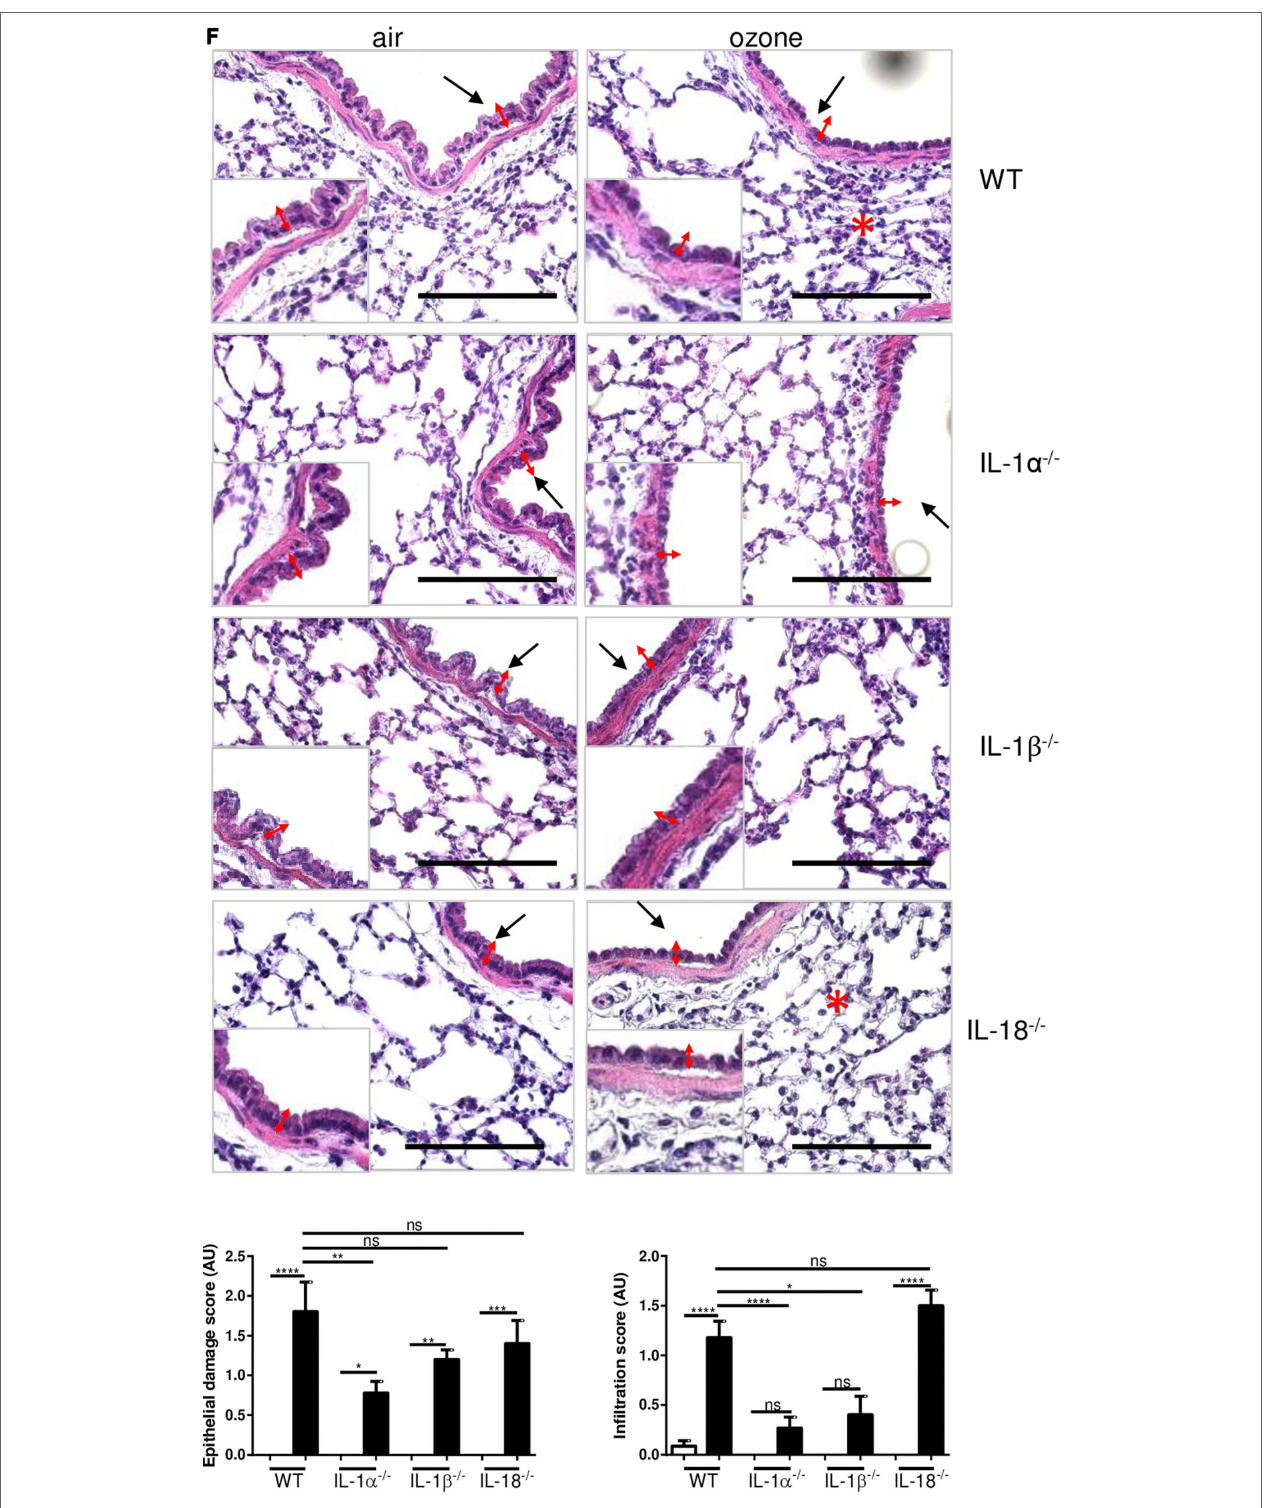
FigUre 2 | Inflammation in interleukin (IL-1) α − / − , IL-1 β − / − , and IL-18 − / − mice 24 h after ozone exposure. Total cells (a) , neutrophils and myeloperoxidase (B) , protein and lipocalin-2 (c) , tissue remodeling parameters, tissue inhibitor metalloproteinase 1, and matrix metalloproteinase 9 (D) , histology, scale bar = 100 µm (F) , in IL-1 α − / − , IL-1 β − / − , and IL-18 − / − mice and airway hyperreactivity in IL-1 α − / − mice (e) , and microscopic analysis of the lung (F) at 24 h after ozone exposure. Representative data of two-independent experiments are shown. Results are expressed as mean ± SEM and are from one experiment, with n = 5–7. Statistical test: ordinary one-way ANOVA, with Bonferroni post test, p value: **** < 0.0001, *** < 0.001, ** < 0.01, * < 0.05.